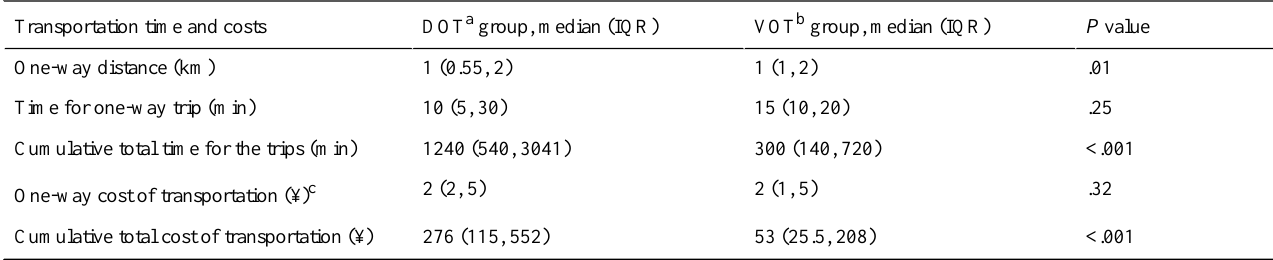
Table 4. Transportation time to the community health service center and the transportation costs incurred by the